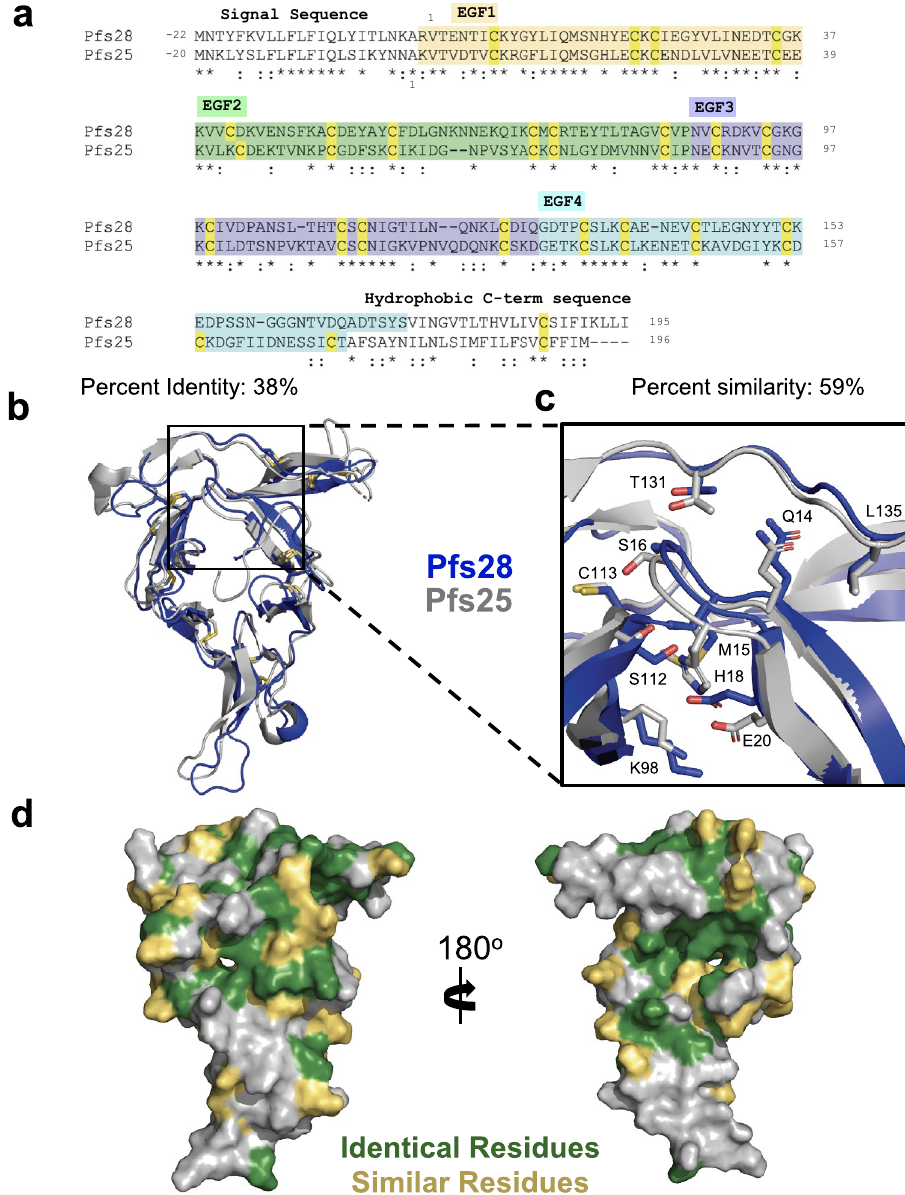
Figure 4. Structural similarity between Pfs25 and Pfs28. ( a ) Sequence alignment of Pfs28 and Pfs25 generated using Clustal Omega 30,31 and shaded in wheat, green, purple, and blue according to EGF-like domain. Identical residues indicated with ‘*’ and chemically similar residues indicated with “:” Cysteines are highlighted in yellow. ( b ) Superposition of Pfs28 structure (blue) and Pfs25 (grey) (PDB ID: 6PHB) 16 with disulfide bridges indicated in yellow. ( c ) Detailed views of conserved residues that stabilize triangular arrangement of EGF domains in Pfs25 (PDB ID: 6PHB) 16 and Pfs28. ( d ) Surface representation of Pfs28 (grey) with identical residues colored green and chemically similar residues colored